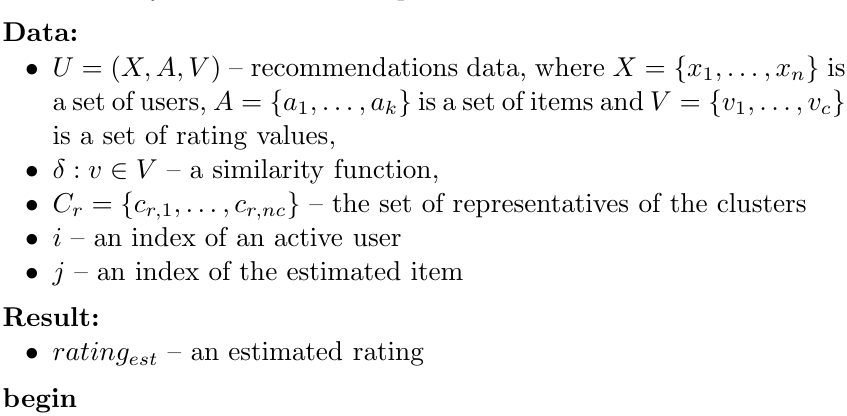
Algorithm 3: The procedure of rating estimation in the